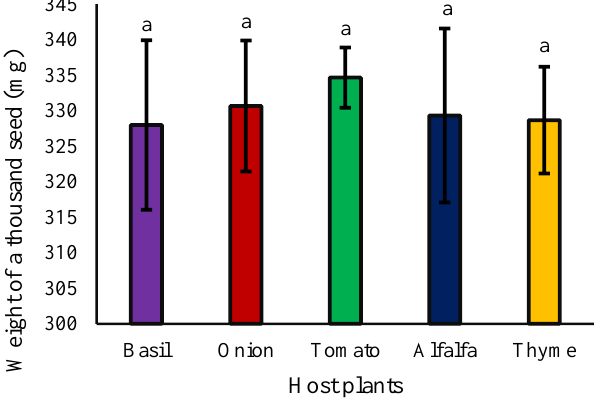
Figure 4. The effect of different hosts on the weight of a thousand seeds of field dodder ( Cuscuta